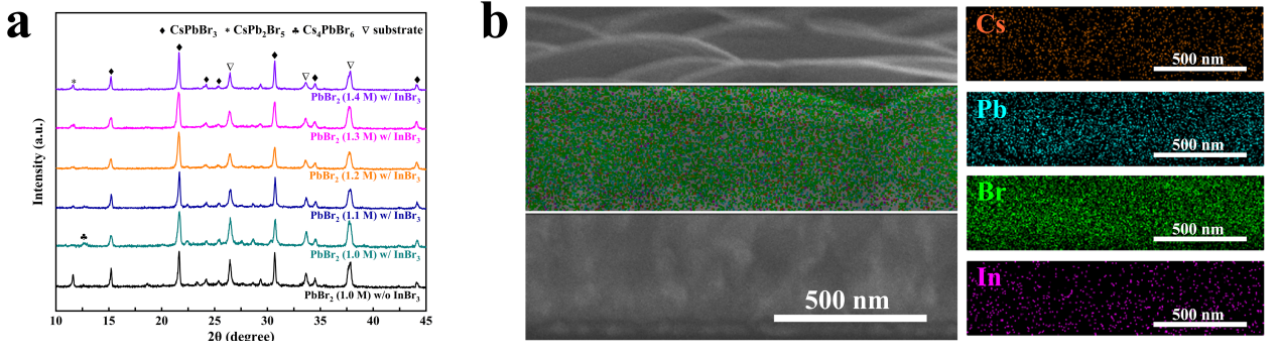
Figure 3. ( a ) XRD patterns of InBr 3 :CsPbBr 3 films synthesized with different PbBr 2 concentration; ( b ) elemental distribution mapping images of the InBr 3 :CsPbBr 3 synthesized with the PbBr 2 concentration of 1.3 M.